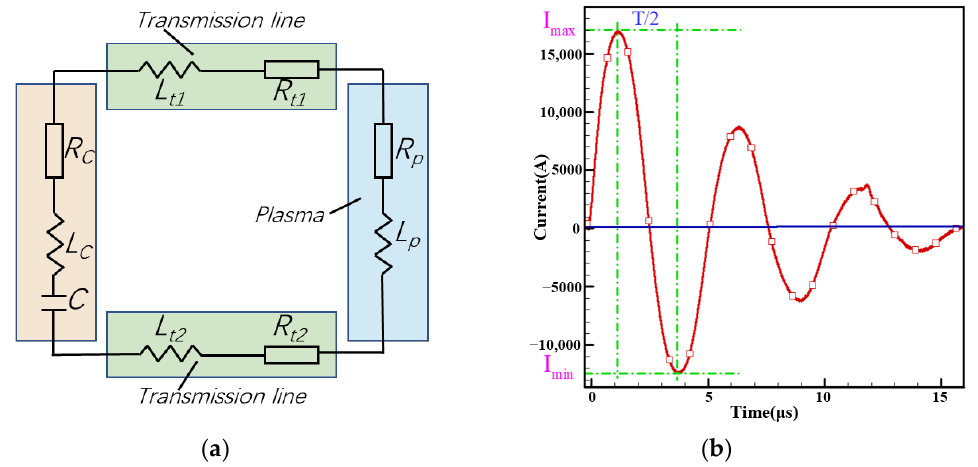
Figure 4. ( a ) Equivalent circuit diagram and ( b ) typical discharge current waveform of the APPT.